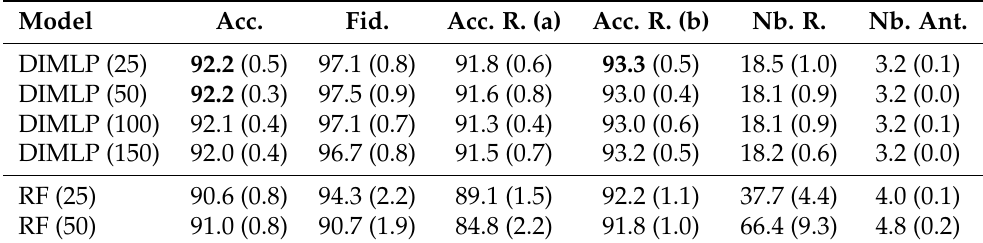
Table 8. Average results obtained on the “Students-on-Math” dataset. For each column, the highest average accuracy or average fidelity is represented in bold, along with the lowest average number of rules or average number of